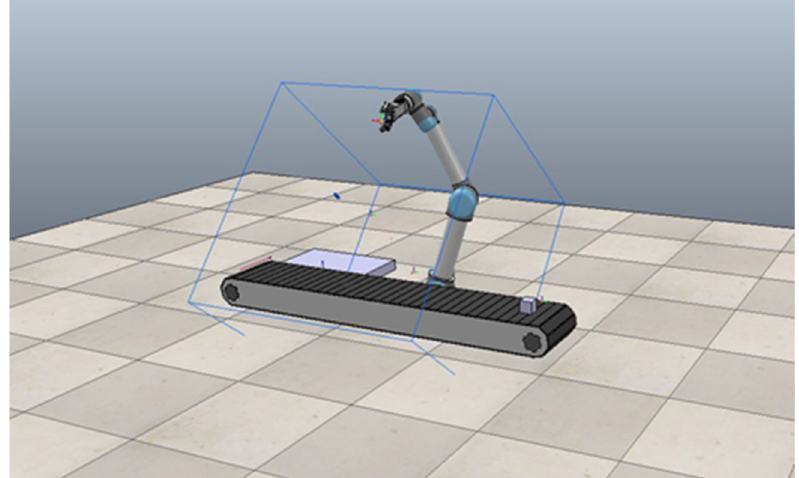
Figure 10. Simulation experiment scene.